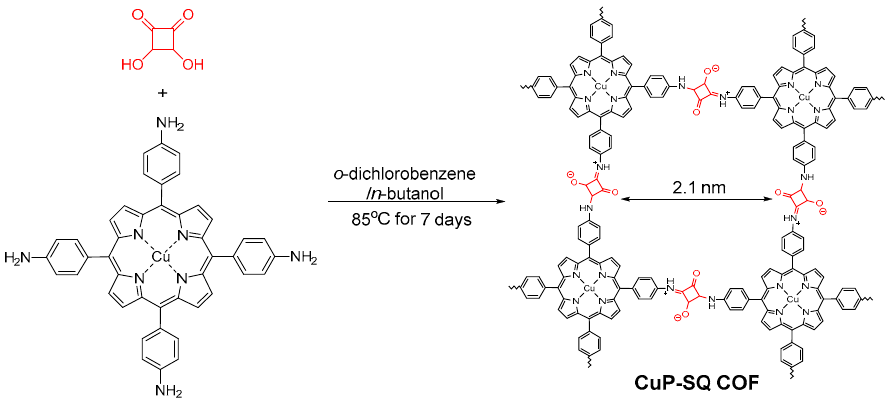
Figure 21. Synthetic reaction of squaraine-linked COFs (CuP-SQ COF).